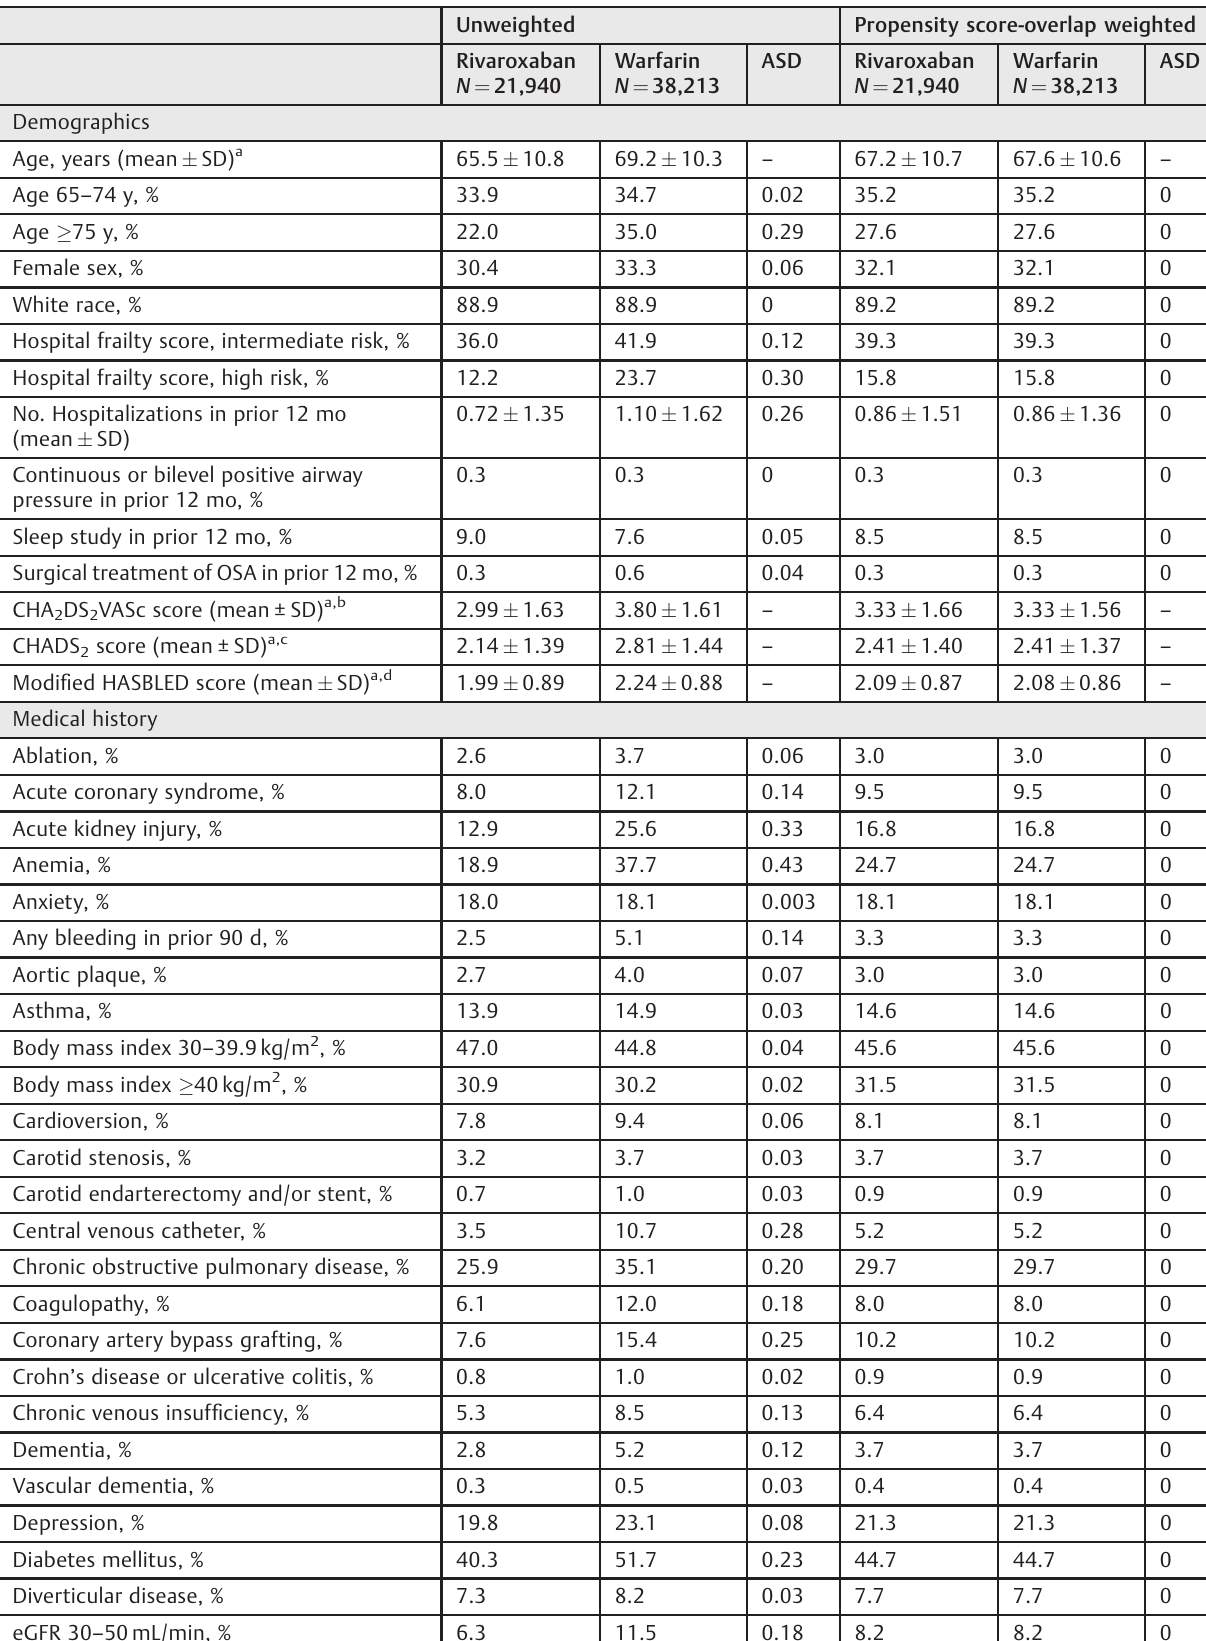
Table 1 Characteristics of included patients in the propensity score overlap weighted